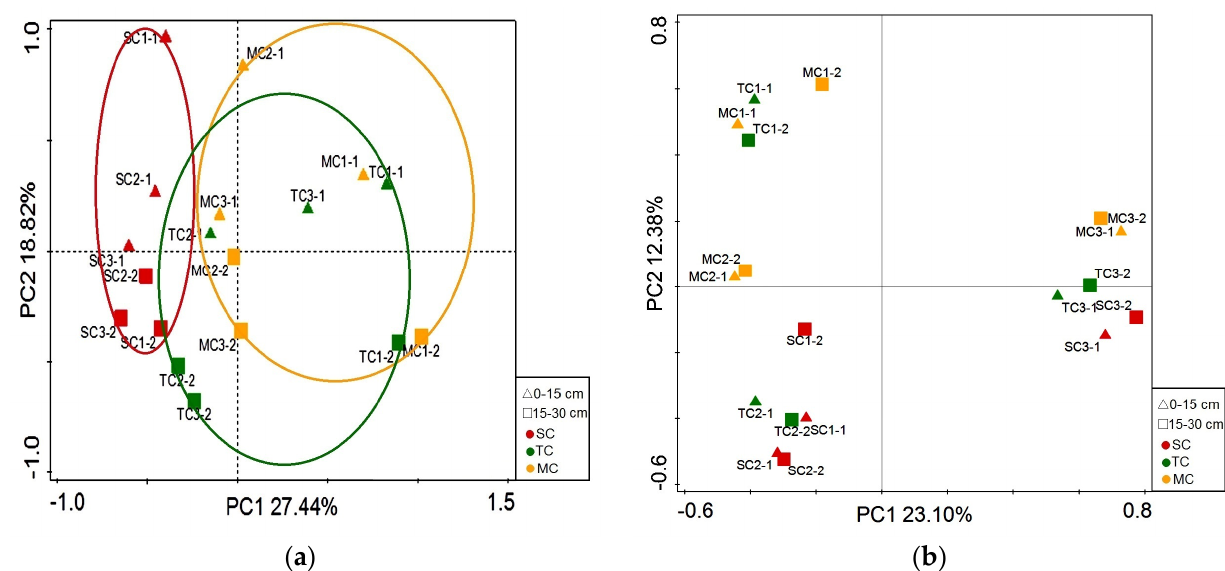
Figure 5. Results of PCoA showing the first two principal coordinates that combined explain 46.26% and 35.48% of the observed variation in bacterial ( a ) and fungal ( b ) community. The shapes of up triangle and square on the figure legend correspond to the soil layer of 0–15 cm and 15–30 cm, and the colors of red, green, and yellow correspond to the SC, TC, and MC communities, respectively. The ellipsoids corresponds to the differences among plant communities (PerMANOVA test, p < 0.05).